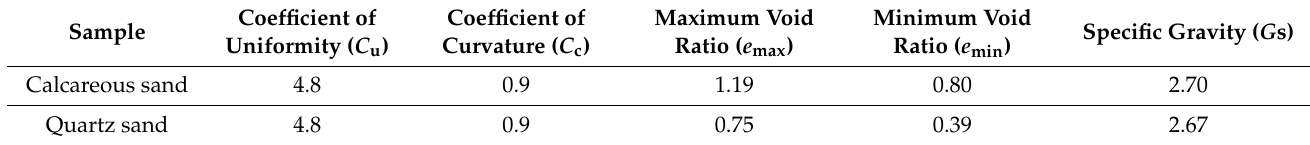
Table 2. Basic property parameters of the test sands ( P 0.25 = 35%).